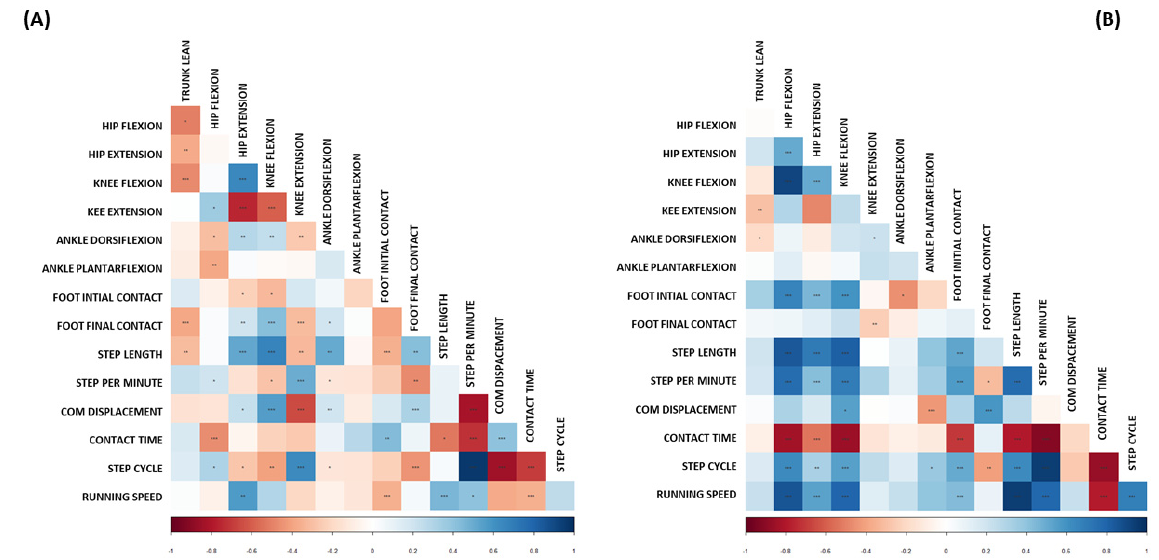
Figure 1. Correlation matrices of impact peak presence group (A) and impact peak absence group ( B ). The figure ( A ) presents a majority of negative correlations (red color); the figure ( B ) presents a majority of positive correlations (blue color). *** = p < 0.01, ** = p < 0.05, * = p < 0.1. The IP group demonstrated a general occurrence of negative correlations, according to matrix color. The n-IP group generally presented positive correlations.